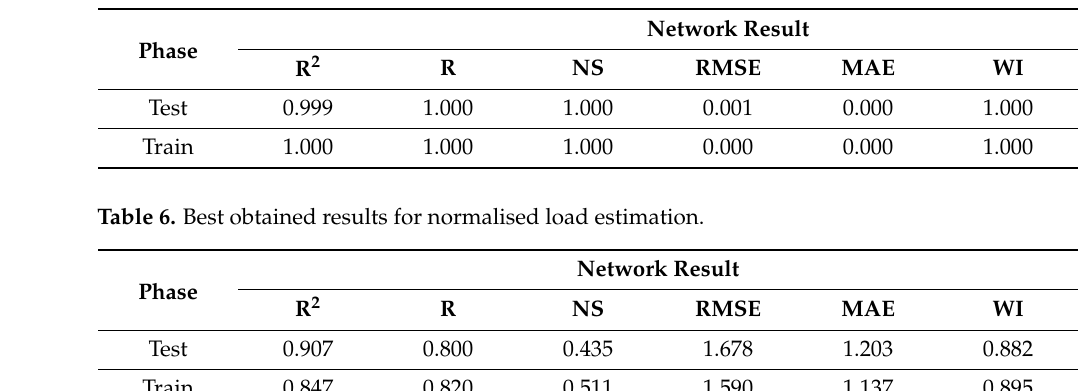
Table 5. Best achieved results for displacement estimation.